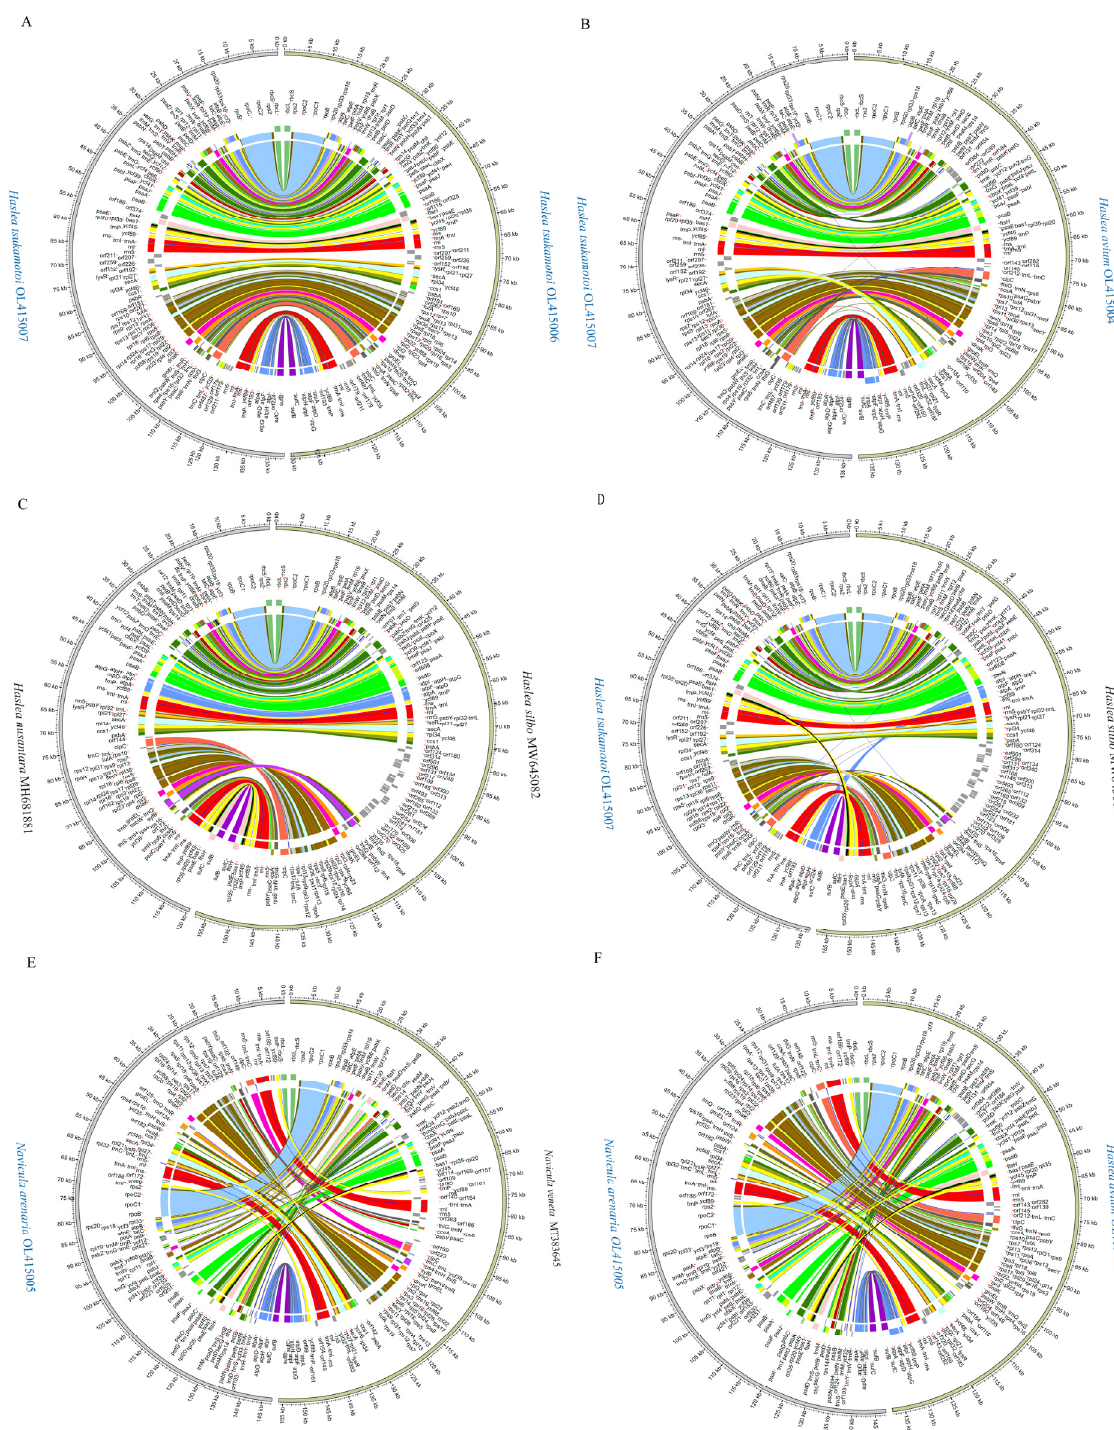
Figure 8. Pair-wise comparison of representative Naviculales cpDNAs. ( A ) The comparative analysis of Haslea tsukamotoi OK415006 and Haslea tsukamotoi OK415007 cpDNAs. ( B ) The comparative analysis of Haslea avium OK415004 and Haslea tsukamotoi OK415007 cpDNAs. ( C ) The comparative analysis of Haslea silbo MW646082 and Haslea nusantara MH681881 cpDNAs. ( D ) The comparative analysis of Haslea silbo MW646082 and Haslea tsukamotoi OK415007 cpDNAs. ( E ) The comparative analysis of Navicula arenaria OK415005 and Navicula veneta MT383645cpDNAs. ( F ) The comparative analysis of Navicula arenaria OK415005 and Haslea avium OK415004 cpDNAs. The assignment of genes into different functional groups is indicated by colors.